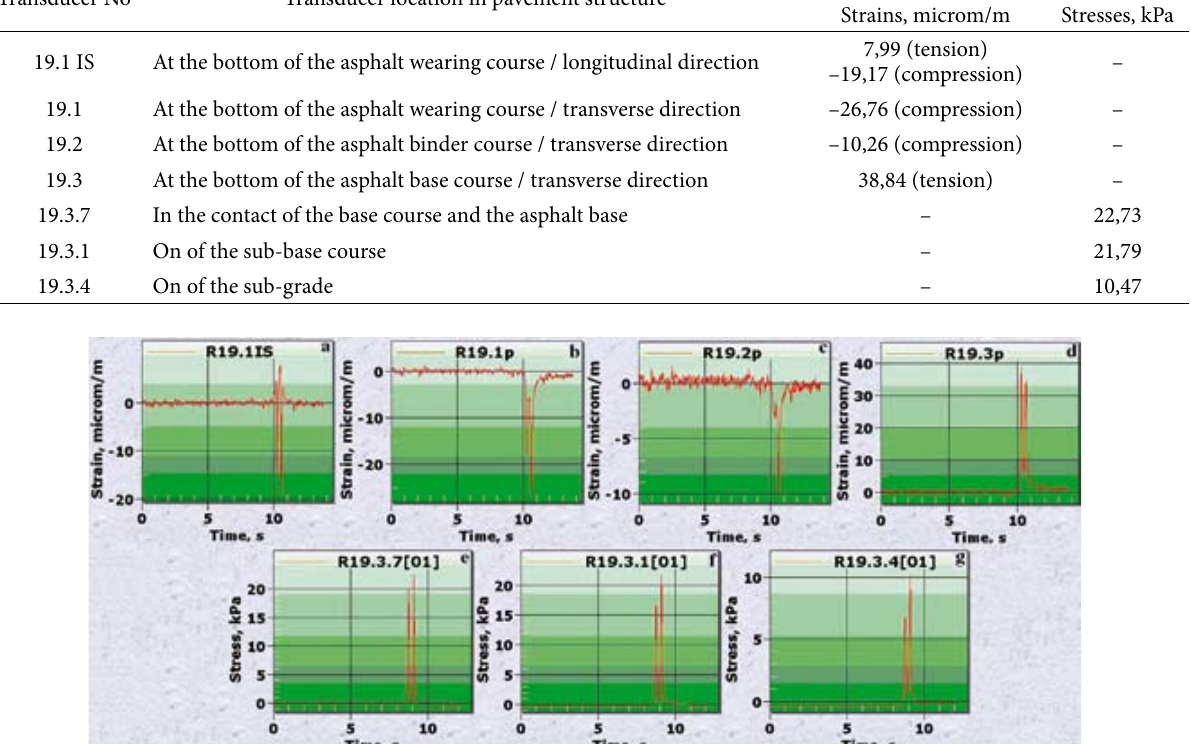
fig. 5. The charts of stresses and strains of the main pavement structure of a test road section: a) longitudinal strain * at the bottom of the asphalt wearing course, b) transverse strain ** at the bottom of the asphalt wearing course, c) transverse strain at the bottom of the asphalt binder course, d) transverse strain at the bottom of the asphalt base course, e) stress in the contact of the asphalt base course and the base, f) stress on of the sub-base course, g) stress on of the sub-grade. * strain measured along wheel travel direction; ** strain measured across wheel travel